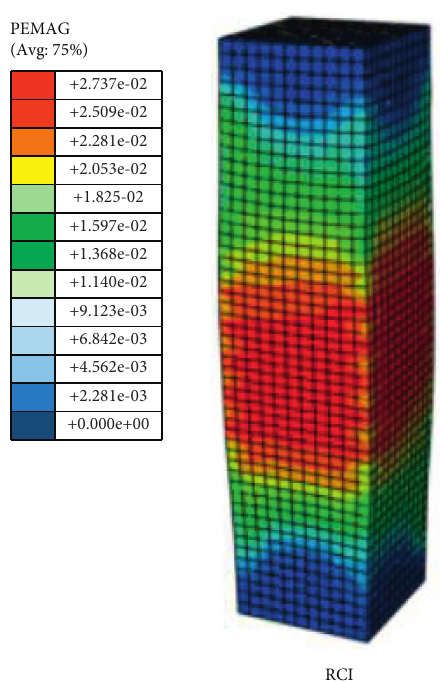
Figure 11: Strain cloud picture of RC1 (MPa).